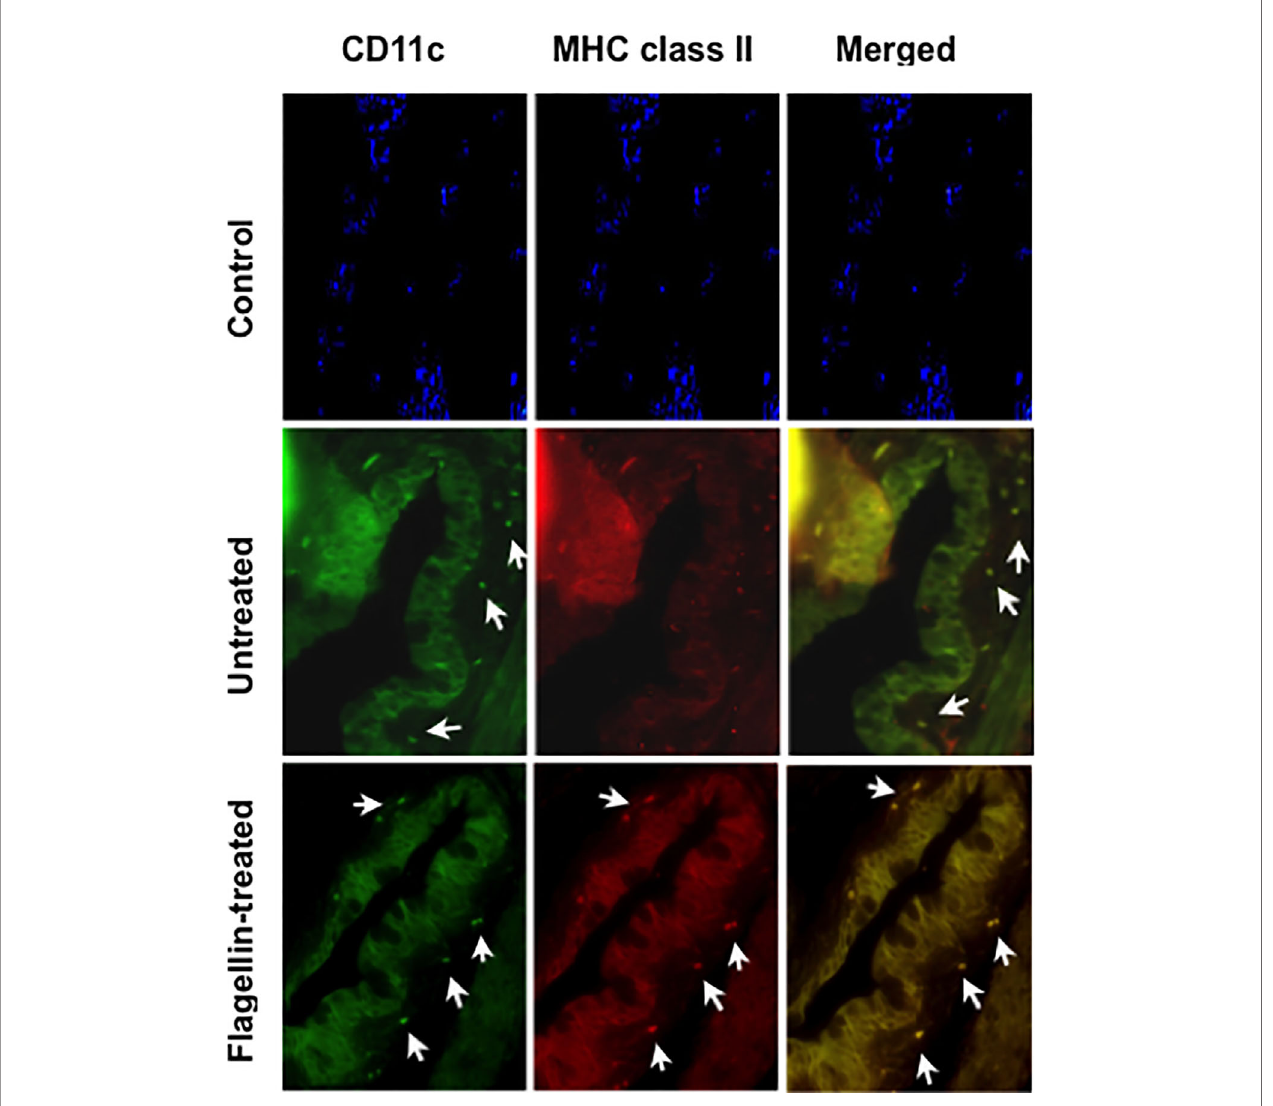
FIGURE 6 | Topically applied fl agellin increases proportion of MHC class II expressing DCs in the conjunctiva. Frozen sections of conjunctiva harvested from either untreated or fl agellin-treated mice (10 ng/day for 7 days) were immunostained for dendritic cell marker CD11c and their activation marker MHC class II. Nuclei were stained with DAPI (blue). White arrows indicate positively stained cells. Magni fi cation